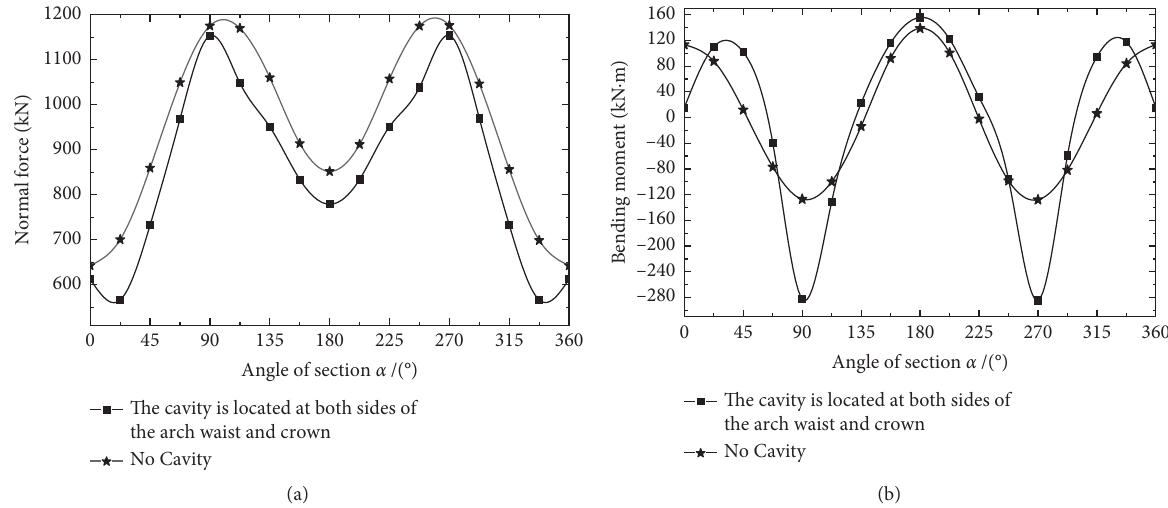
Figure 29: Internal force diagram of the cavity behind the arch waist and vault on both sides. (a) Segment axial force. (b) Segment bending